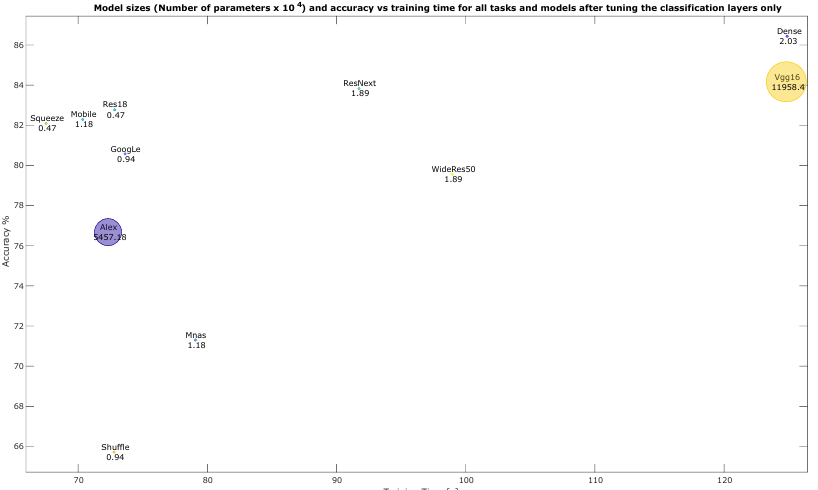
Figure 5. Model sizes and accuracy vs. training time for all tasks and models after fine-tuning full layers.